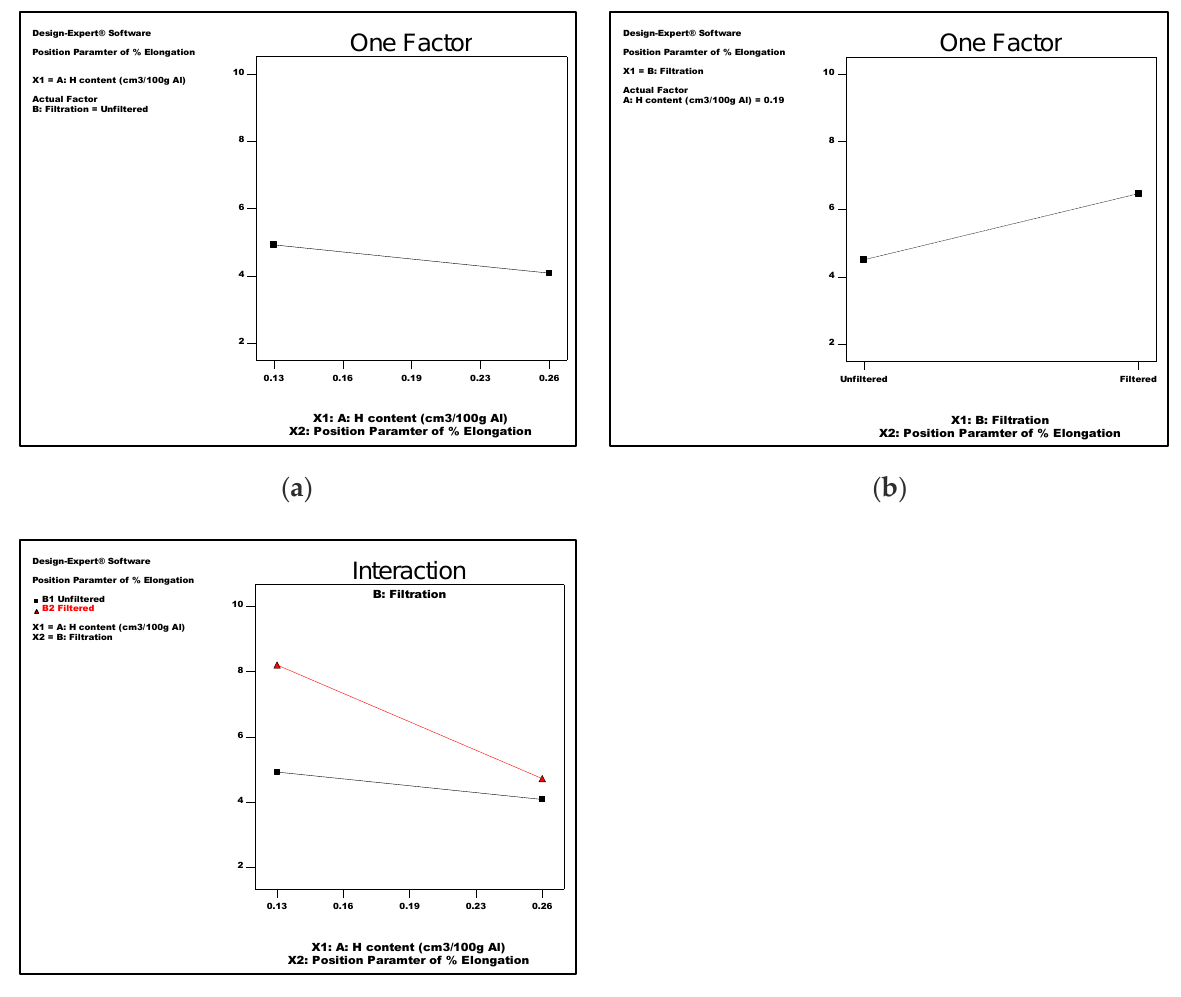
Figure 7. Graphs of ( a ) hydrogen level, ( b ) filtration, ( c ) the interaction between hydrogen level and filtration against x 0)ELONG .